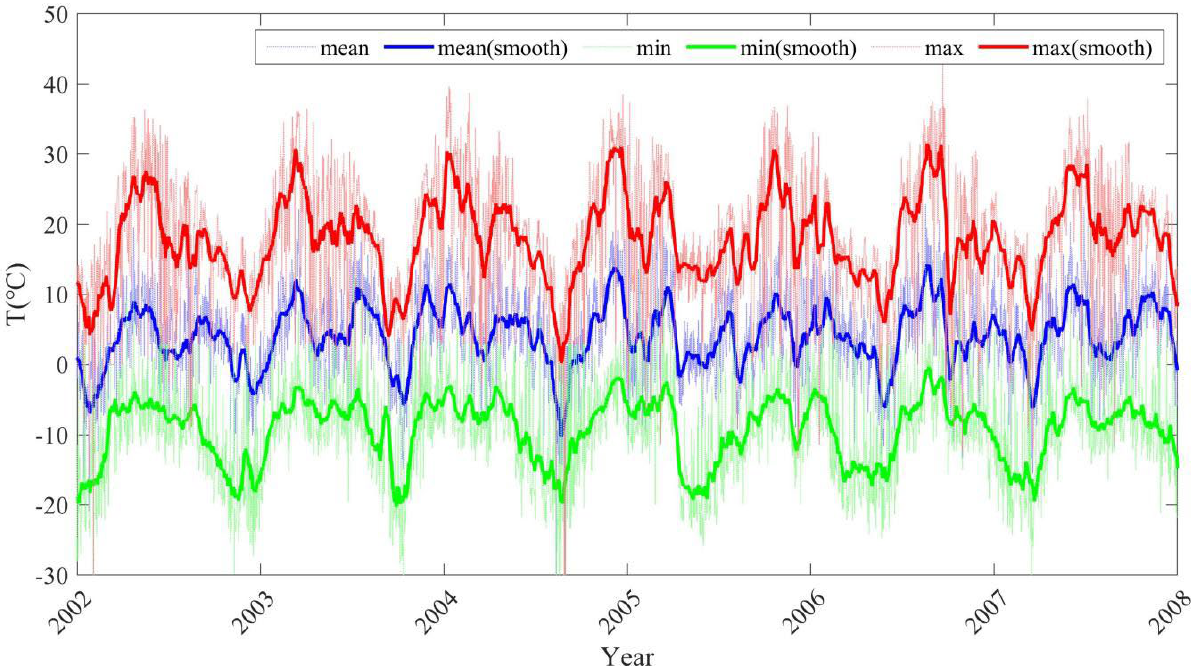
Figure 2. The glacier surface temperature data for the Yala Glacier. In the figure, we have shown the daily mean, minimum and maximum temperatures from MOD11A1 and MYD11A1 products.